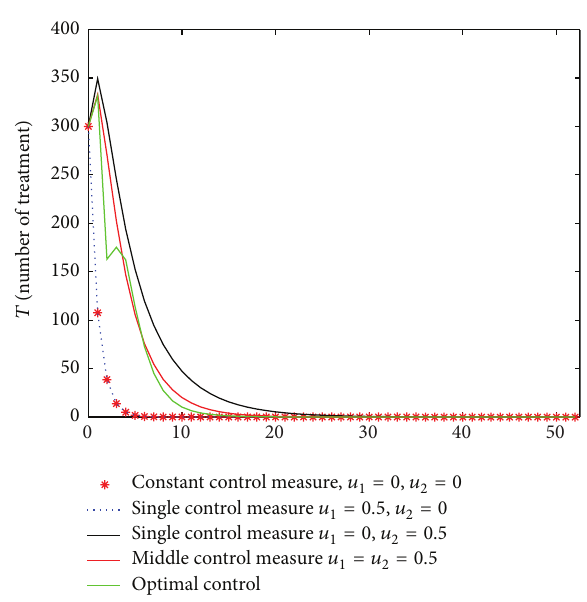
Figure 13: Number of the persons in treatment when we choose the weights in objective function are 𝑐 1 = 10 4 , 𝑐 2 = 10 2 and under different optimal control strategies, that is, (1) without control: 𝑢 1 = = 0 ; (2) single control: 𝑢 = 0.5 , 𝑢 = 0 ; (3) single control: 𝑢 𝑢 2 1 2 = 0.5 ; (4) middle control: 𝑢 = 𝑢 = 0.5 ; (5) optimal control: 𝑢 2 1 2 = 𝑢 ∗ 𝑢 = 𝑢 ∗ 𝑢 1 2 1 , 2 .